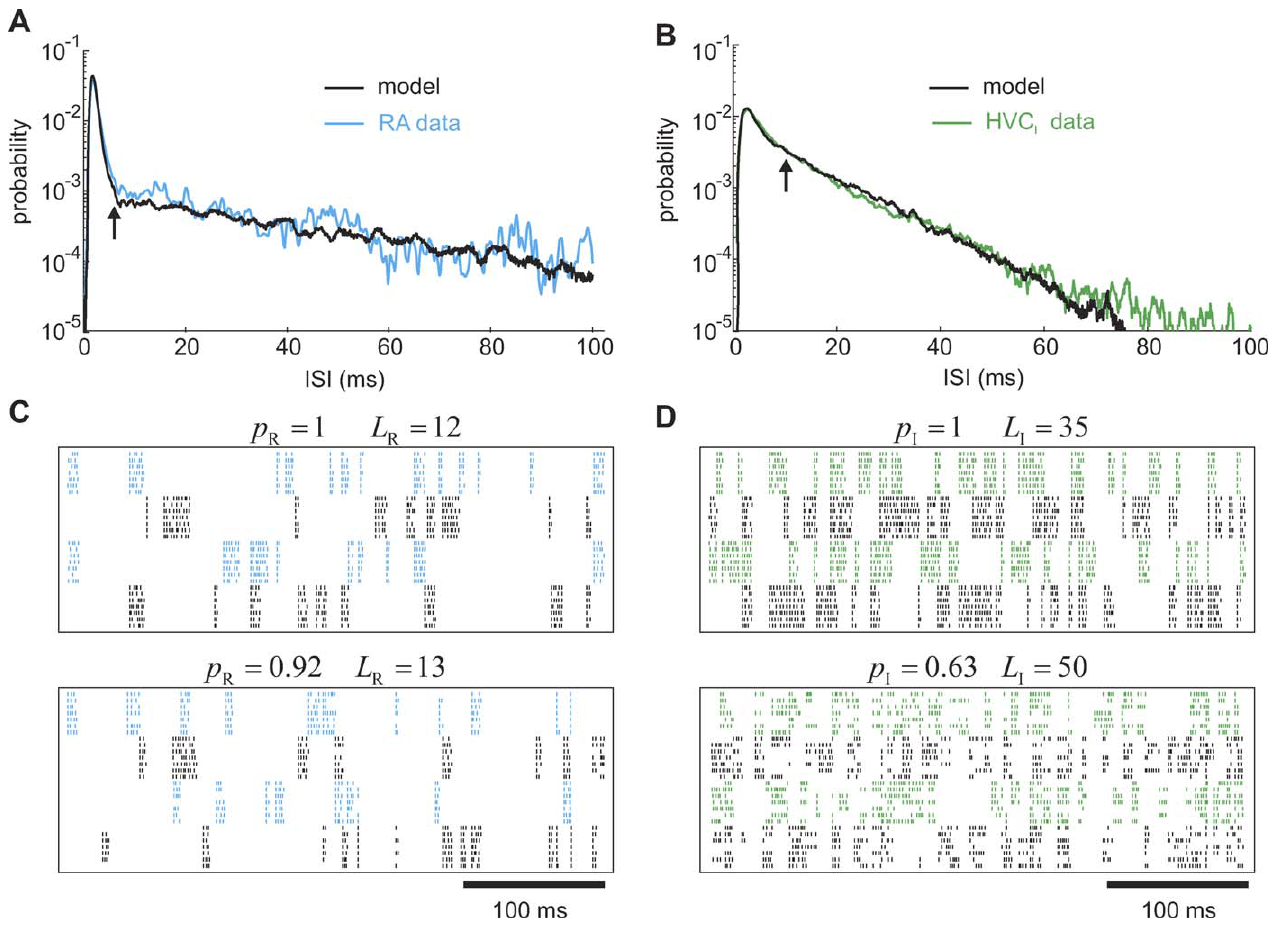
Figure 3. Song-Related ISI pdfs of RA and HVC I Neurons (A,B) Model-based fits of averaged ISI pdfs in RA and HVC I neurons during singing. The arrows delimit the ISI range of the burst models in Figure 2C, i.e., 6 ms and 10 ms, respectively. The RA-neuron data (A) were taken from [10], and the HVC I data (B) were provided courtesy of A. Kozhevnikov. L R ¼ 12, and L I ¼ 35. (C,D) Raster plots of song-related spike trains in four RA and four HVC I model neurons for two different values of link counts L R/I and burst probabilities p R/I . Spikes are represented as tick marks and drawn in alternating colors for different neurons.